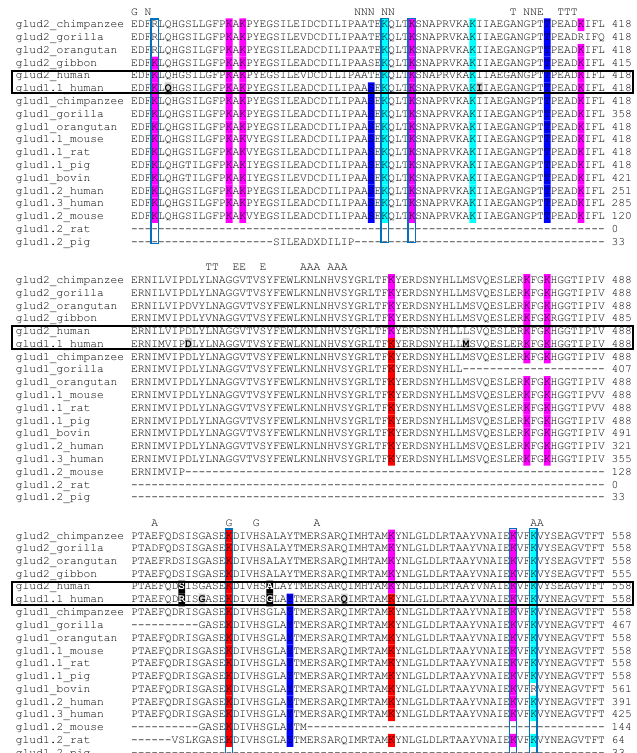
AA glud2_chimpanzee PTAEFQDSISGASEKDIVHSALAYTMERSARQIMHTAMKYNLGLDLRTAAYVNAIEKVFKVYSEAGVTFT 558 glud2_gorilla PTADFQDSISGASEKDIVHSALAYTMERSARQIMHTAMKYNLGLDLRTAAYVNAIEKVFKVYSEAGVTFT 558 glud2_orangutan PTAEFRDSISGASEKDIVHSALAYTMERSARQIMHTAMKYNLGLDLRTAAYVNAIEKVFKVYSEAGVTFT 558 glud2_gibbon PTAEFQDSISGASEKDIVHSALAYTMERSARQIMRTAMKYNLGLDLRTAAYVNAIEKVFKVYSEAGVTFT 555 glud2_human PTAEFQD S ISGASEKDIVHS A LAYTMERSARQIMHTAMKYNLGLDLRTAAYVNAIEKVFKVYSEAGVTFT 558 glud1.1_human PTAEFQD R IS G ASEKDIVHS G LAYTMERSAR Q IMRTAMKYNLGLDLRTAAYVNAIEKVFKVYNEAGVTFT 558 glud1_chimpanzee PTAEFQDRISGASEKDIVHSGLAYTMERSARQIMRTAMKYNLGLDLRTAAYVNAIEKVFKVYNEAGVTFT 558 glud1_gorilla ----------GASEKDIVHSGLAYTMERSARQIMRTAMKYNLGLDLRTAAYVNAIEKVFKVYNEAGVTFT 467 glud1_orangutan PTAEFQDRISGASEKDIVHSGLAYTMERSARQIMRTAMKYNLGLDLRTAAYVNAIEKVFKVYNEAGVTFT 558 glud1.1_mouse PTAEFQDRISGASEKDIVHSGLAYTMERSARQIMRTAMKYNLGLDLRTAAYVNAIEKVFKVYNEAGVTFT 558 glud1.1_rat PTAEFQDRISGASEKDIVHSGLAYTMERSARQIMRTAMKYNLGLDLRTAAYVNAIEKVFKVYNEAGVTFT 558 glud1.1_pig PTAEFQDRISGASEKDIVHSGLAYTMERSARQIMRTAMKYNLGLDLRTAAYVNAIEKVFKVYNEAGVTFT 558 glud1_bovin PTAEFQDRISGASEKDIVHSGLAYTMERSARQIMRTAMKYNLGLDLRTAAYVNAIEKVFRVYNEAGVTFT 561 glud1.2_human PTAEFQDRISGASEKDIVHSGLAYTMERSARQIMRTAMKYNLGLDLRTAAYVNAIEKVFKVYNEAGVTFT 391 glud1.3_human PTAEFQDRISGASEKDIVHSGLAYTMERSARQIMRTAMKYNLGLDLRTAAYVNAIEKVFKVYNEAGVTFT 425 glud1.2_mouse ----------GASEKDIVHSGLAYTM-------------------------------------------- 144 glud1.2_rat ------VSLKGASEKDIVHSGLAYTMERSARQIMRTAMKYNLGLDLRTAAYVNAIEKVFKVYNEAGVTFT 64 glud1.2_pig ---------------------------------------------------------------------- 33 Figure 2. Multiple alignments of glutamate dehydrogenase isoenzymes and isoforms using ClustalW. Canonical sequences and/or their splice variants were extracted from UniProtKB protein knowledgebase (http://www.uniprot.org/). The sequences of the following proteins were used for the alignment: Homo sapiens (three splice variants of the GLUD1 gene and the single product of GLUD2 gene); apes, including Pan troglodytes , Gorilla gorilla and Pongo abelii (major product of GLUD1 gene and the single product of GLUD2 gene); Hylobates lar (only the product of GLUD2 gene is included); Rattus norvegicus , Mus musculus and Sus scrofa (major and truncated products of GLUD1 gene); Bos taurus (major product of GLUD1 gene). Residue numbering includes the mitochondrial target peptide residues which are highlighted in dark grey. Electrostatic charge-affecting differences in the mitochondrial target peptide residues of human GDH isoenzymes are shown in white. The conservative ADP-ribosylated cysteine residue is highlighted in yellow. Serine, threonine and tyrosine residues subjected to phosphorylation are highlighted in dark blue. Lysine residues subjected to acetylation are highlighted in light blue, to succinylation—in green, to acetylation and succinylation—in pink, to acetylation, succinylation and malonylation—in red. Letters on the top mark the residues involved in the binding of GTP (“G”), NAD + in the active site (“N”), ADP (“A”), glutamate (“E”) and forming the thiamine-binding motif (“T”). Lysine residues of established regulatory significance (discussed in the text) are vertically framed. Pairwise alignment of human glutamate dehydrogenase isoenzymes: hGDH2 ( GLUD2 ) and hGDH1 ( GLUD1 ) is horizontally framed. hGDH1 residues immediately before or within the triplets where the RNA splicing takes place, are marked in light grey and bold. Functional substitutions of hGDH1 residues resulting in the regulatory properties similar to hGDH2 are highlighted in black.